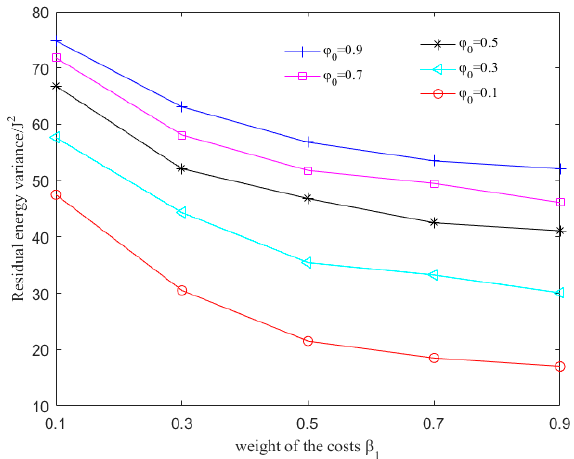
Figure 3. Variance of the residual energy with different values of ϕ 0 , β 1 and β 2